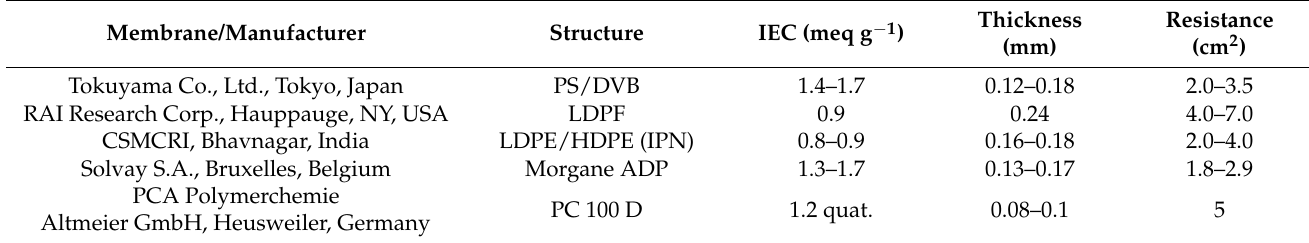
Table 4. Commercial anion exchange membranes and their